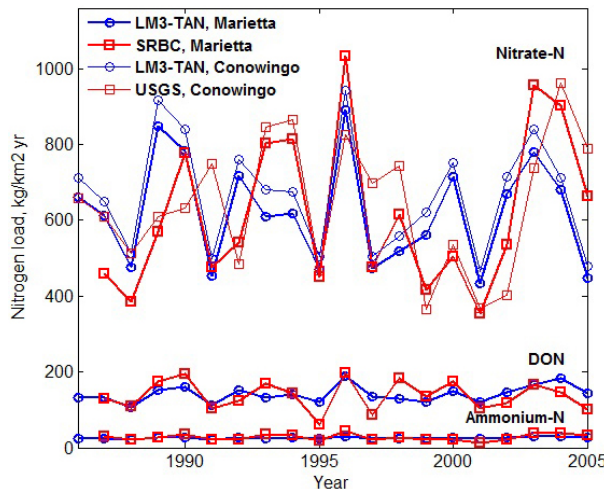
Figure 5. 20year (1986–2005) of the simulated stream N loads (normalized by sub-basin areas) at Marietta and Conowingo and the corresponding reported data from SRBC and